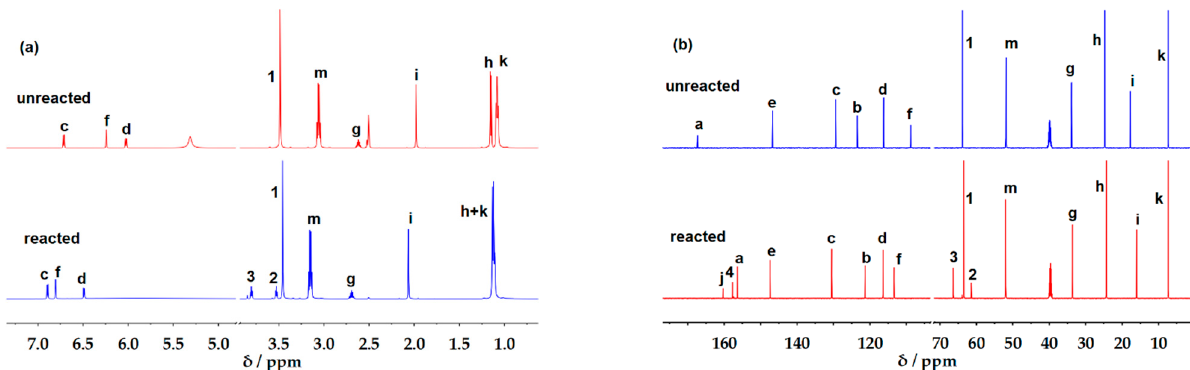
Figure 2. The 1 H ( a ) and 13 C ( b ) NMR spectra of [Et 4 N] [Car]:EG (1:2) before and after CO 2 uptake. Letters from a to i are the labels of hydrogen or carbon atoms of [Car] anion with and without CO 2 . Letters m and k are the labels of hydrogen or carbon atoms of [Et 4 N] cation. Letter j is the label of carbonyl carbon of Car-based carbonate. Numbers 1 is the label of hydrogen or carbon atom of EG. Numbers 2, 3 and 4 are the labels of hydrogen or carbon atoms of EG-based carbonate.